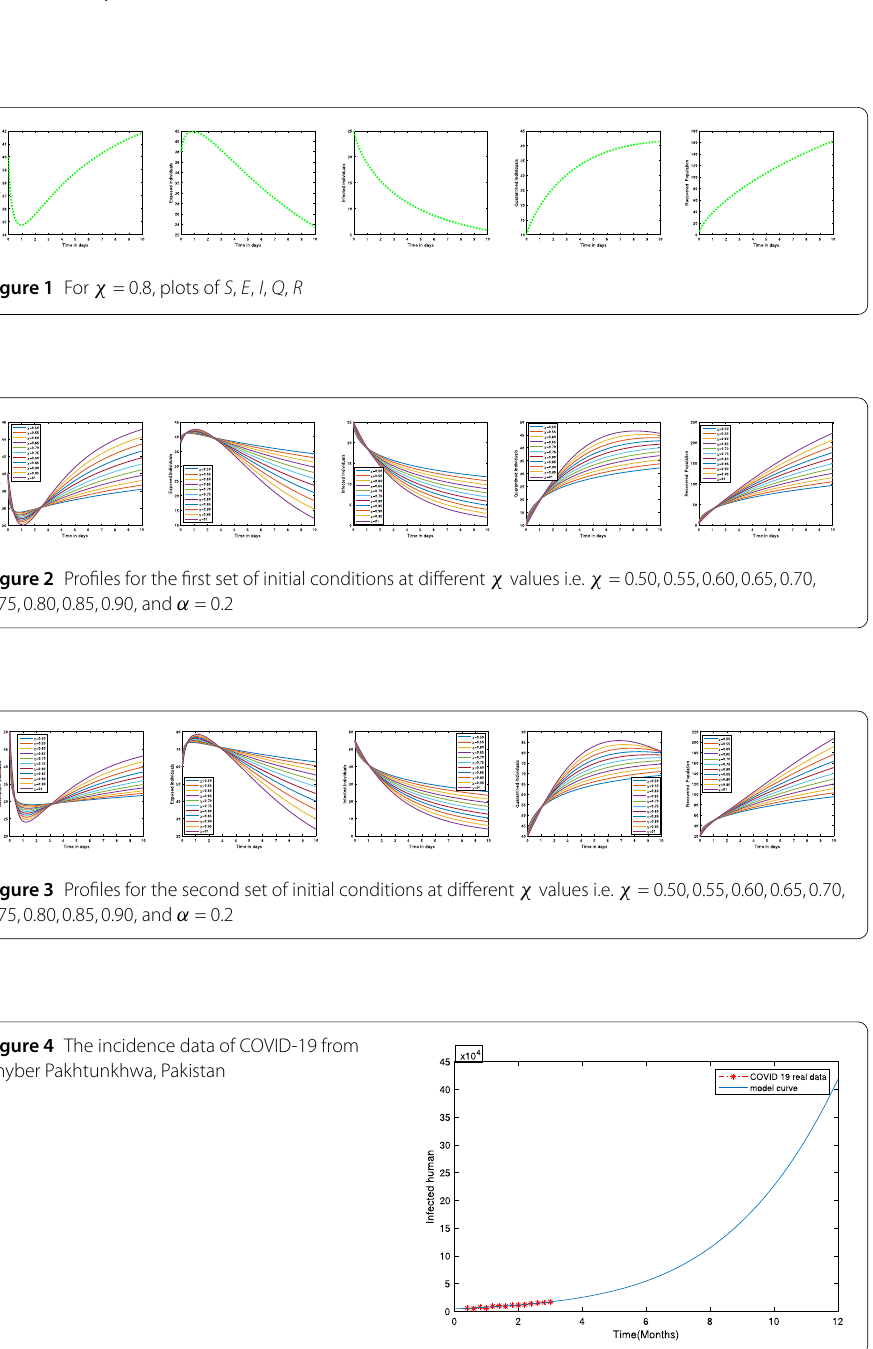
fractional order χ derivative increases. In Fig. 2 the number of the exposed decreases as the fractional order χ value increases. Figure 2 depicts COVID-19 infected people, the number of which decreases as the fractional order derivative increases. Similarly, Fig. 2 depicts quarantined people and the number of quarantined people increases as the frac- tional order derivative increases. In Fig. 2 the recovered human population increases as the fractional order values increase. Figure 3 represents the numerical simulation results for α = 0.3 and for different values of fractional parameter χ . Figure 4. shows the real data plot against the model infected people